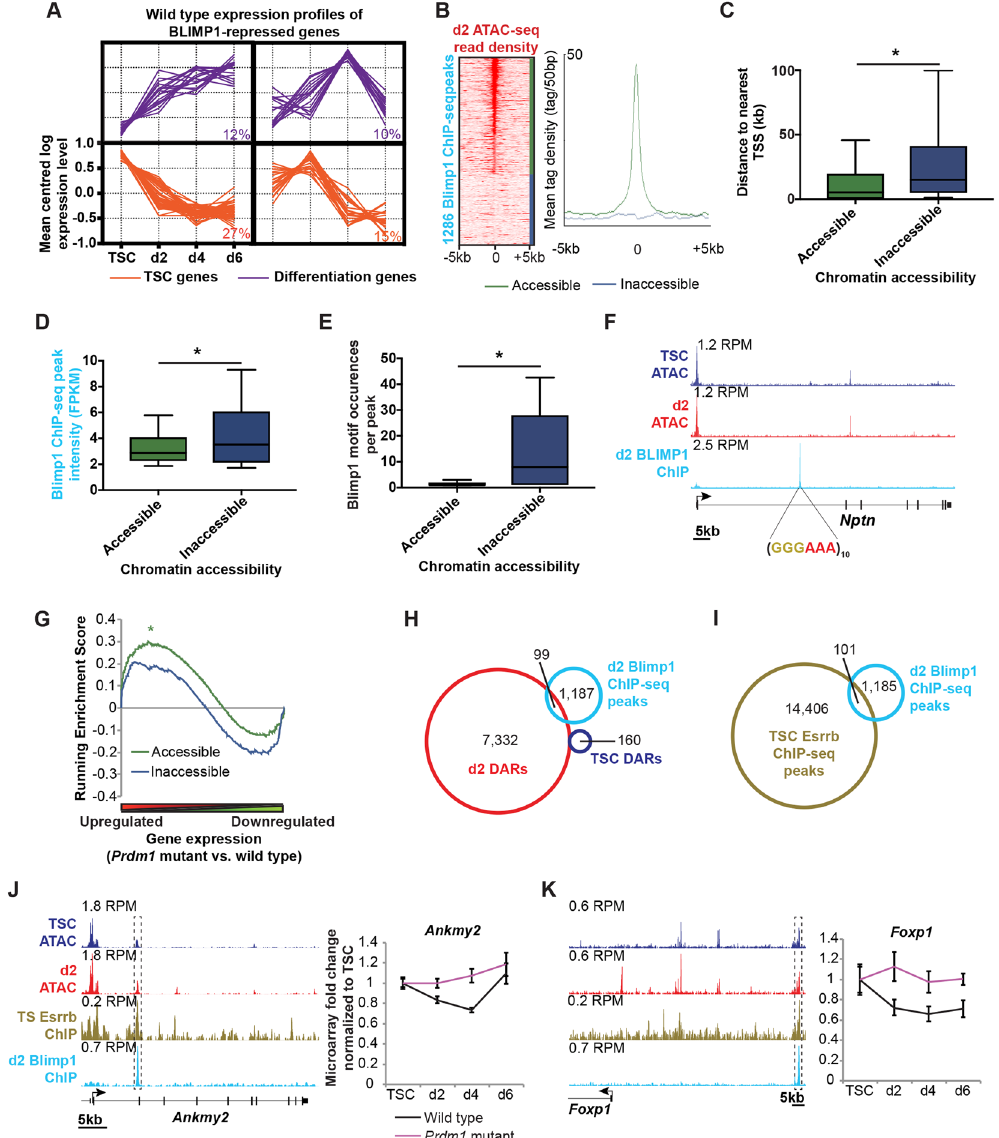
Figure 8. Blimp1 represses TSC gene expression and prevents aberrant induction of differentiation genes. ( A ) K-means clustering of microarray expression profiles of the 125 identified Blimp1 target genes during TSC differentiation. Blimp1 direct target genes include both TSC-expressed genes (orange) and those activated during differentiation (purple). Percentages of genes within each cluster are indicated. ( B ) Heatmap and density plot of d2 ATAC-seq reads at Blimp1 ChIP-seq peaks distinguish Blimp1 occupancy at accessible or inaccessible target sites. ( C ) Distance of Blimp1 ChIP-seq peaks from the nearest TSS at accessible or inaccessible chromatin regions categorized as in panel B. Blotplot intervals indicate median, 10 th , 25 th , 75 th and 90 th percentiles. Statistical significance was calculated using two-tailed heteroscedastic t-test. * P = 1.1 × 10 − 14 . ( D ) Blimp1 ChIP-seq peak intensities at accessible or inaccessible chromatin regions. Statistical significance was calculated using two-tailed heteroscedastic t-test. FPKM = fragments per kilobase per million reads; * P = 2.4 × 10 − 6 . ( E ) Occurrence of the Blimp1 consensus binding motif located within Blimp1 ChIP-seq peaks at accessible or inaccessible chromatin regions. Statistical significance was calculated using two-tailed heteroscedastic t-test. * P = 1.0 × 10 − 44 . ( F ) Blimp1 occupancy at closed chromatin corresponds to low complexity repeats homologous to the Blimp1 consensus binding motif. RPM = Reads per million. ( G ) Gene Set Enrichment Analysis of wild type and Prdm1 mutant trophoblast gene expression profiles at day 2 of differentiation in comparison with Blimp1 ChIP-seq peaks at accessible and inaccessible chromatin (nearest TSS ± 100 kb annotated). * P < 1 × 10 − 3 , FWER P = 5 × 10 − 3 . ( H ) Overlap of d2 Blimp1 ChIP-seq peaks with TSC and d2 DARs. See also Supplementary Figure S2. ( I ) Overlap of d2 Blimp1 ChIP-seq peaks with TSC Esrrb ChIP-seq peaks. See also Supplementary Figure S2. ( J , K ) Blimp1 and Esrrb occupancy at shared ATAC-seq and ChIP-seq peaks in comparison with microarray expression profiles for Ankmy2 ( J ) and Foxp1 ( K ). Data represents means ± S.E.M., n ≥ 6 per genotype per stage. RPM = Reads per